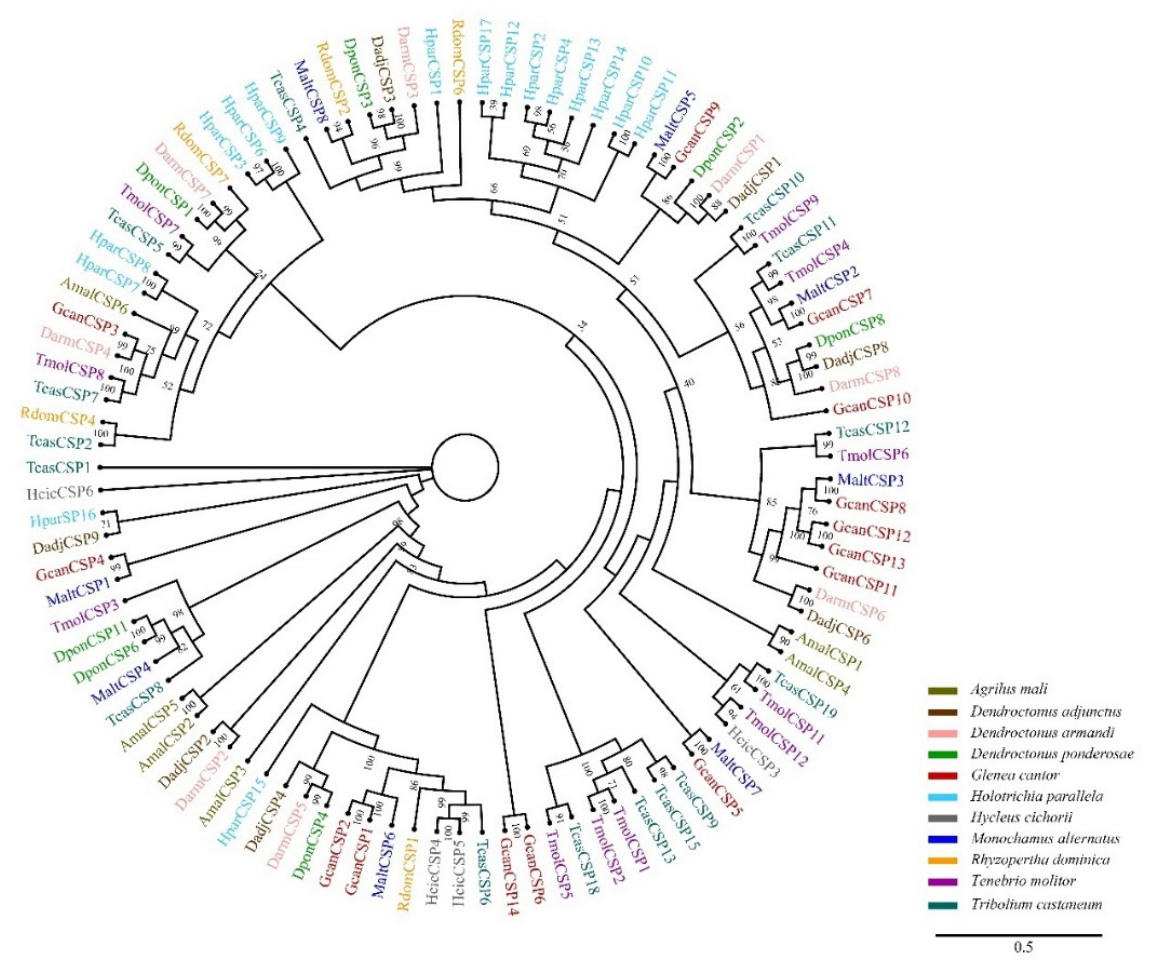
Figure 3. Phylogenetic analysis of insect chemosensory proteins (CSPs). Information of CSPs was listed in Table S4. Agrilus mali (Amal), Dendroctonus adjunctus (Dadj), Dendroctonus armandi (Darm), Dendroctonus ponderosae (Dpon), Holotrichia parallela (Hpar), Hycleus cichorii (Hcic), Monochamus alternatus (Malt), Rhyzopertha dominica (Rdom), Tenebrio molitor (Tmol), and Tribolium castaneum (Tcas).